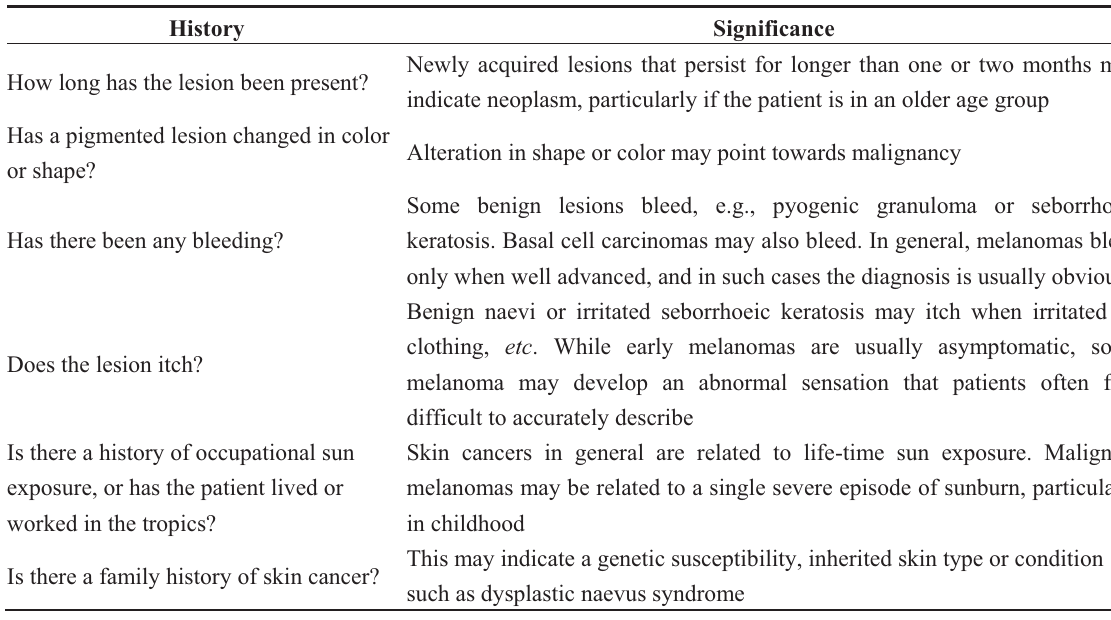
Table 1. Suggested patient history.